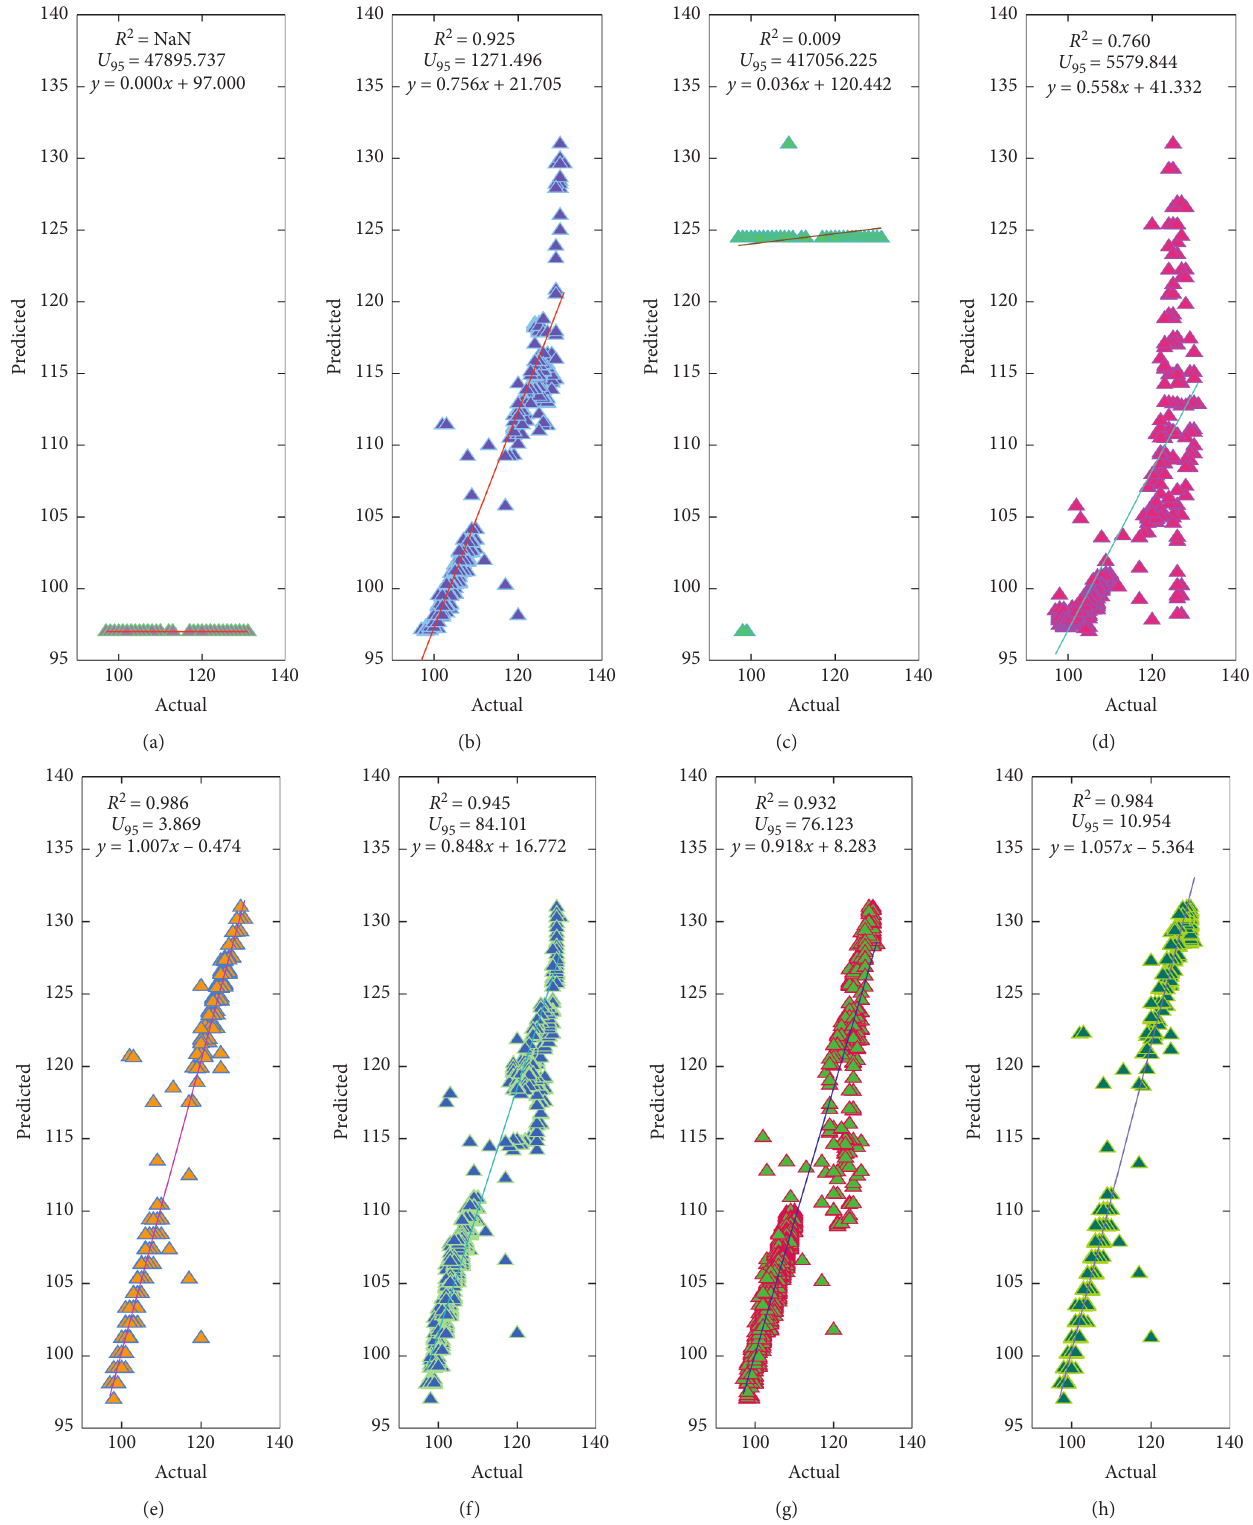
Figure 9: SVR models for USGS 14181500 station: coefficient of determination. (a) SVR-M1. (b) SVR-M2. (c) SVR-M3. (d) SVR-M4. (e) SVR-M5. (f) SVR-M6. (g) SVR-M7. (h)